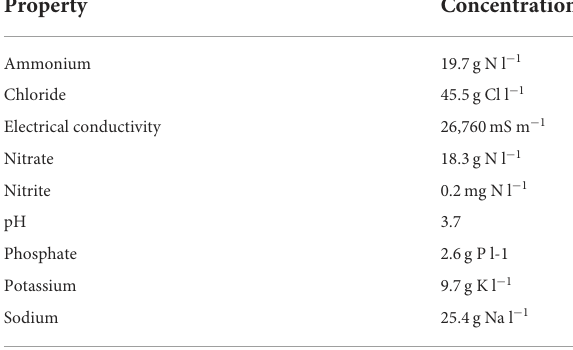
TABLE 1 Chemical properties of the nitrified urine fertilizer (NUF).